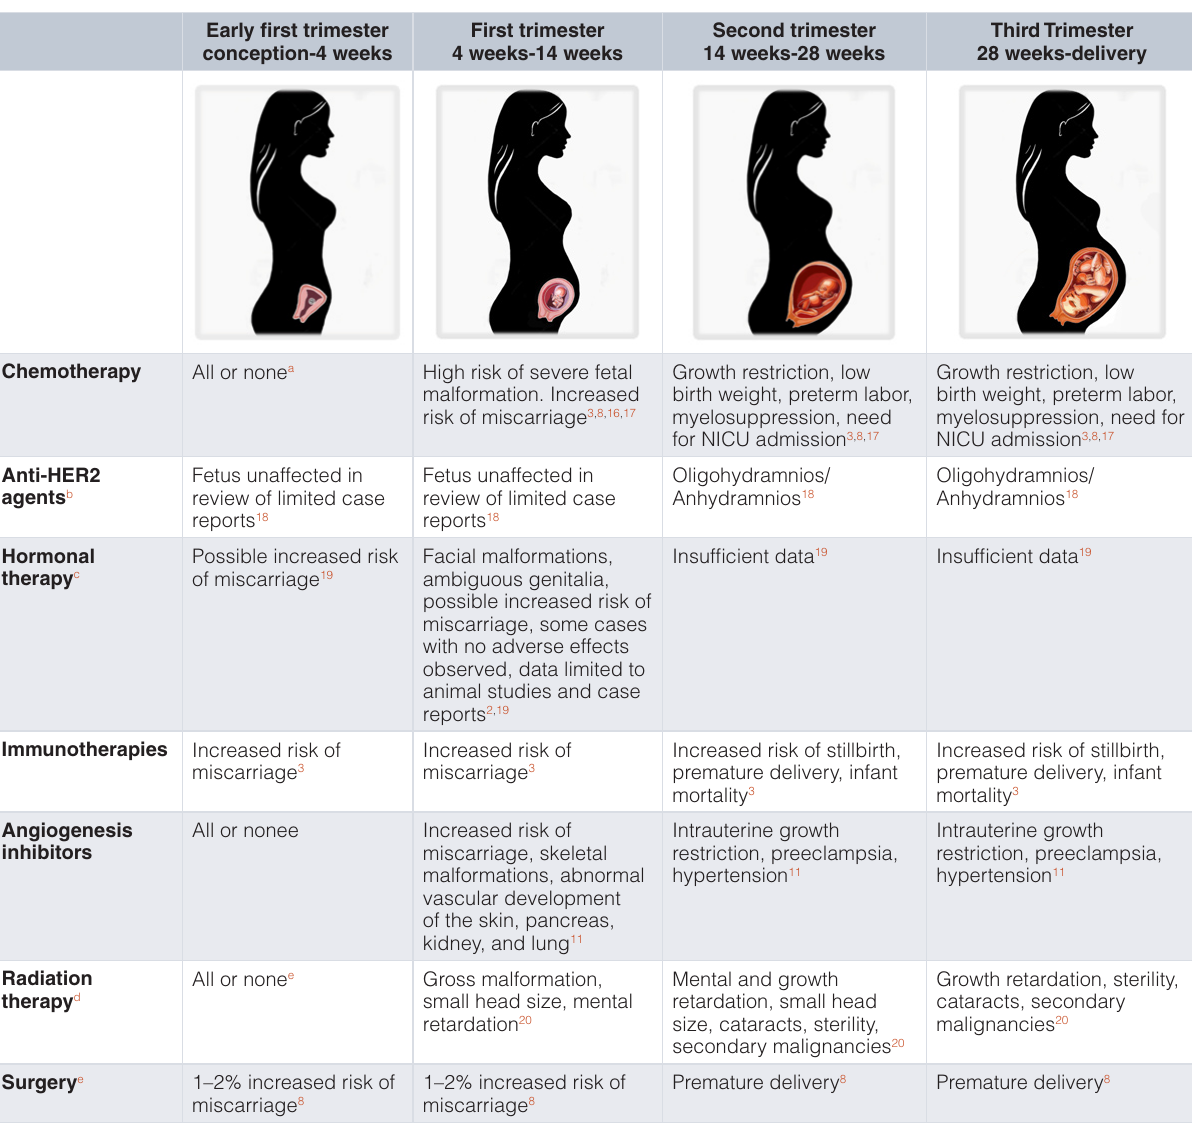
Table 1. Summary of cancer therapies and their effects on